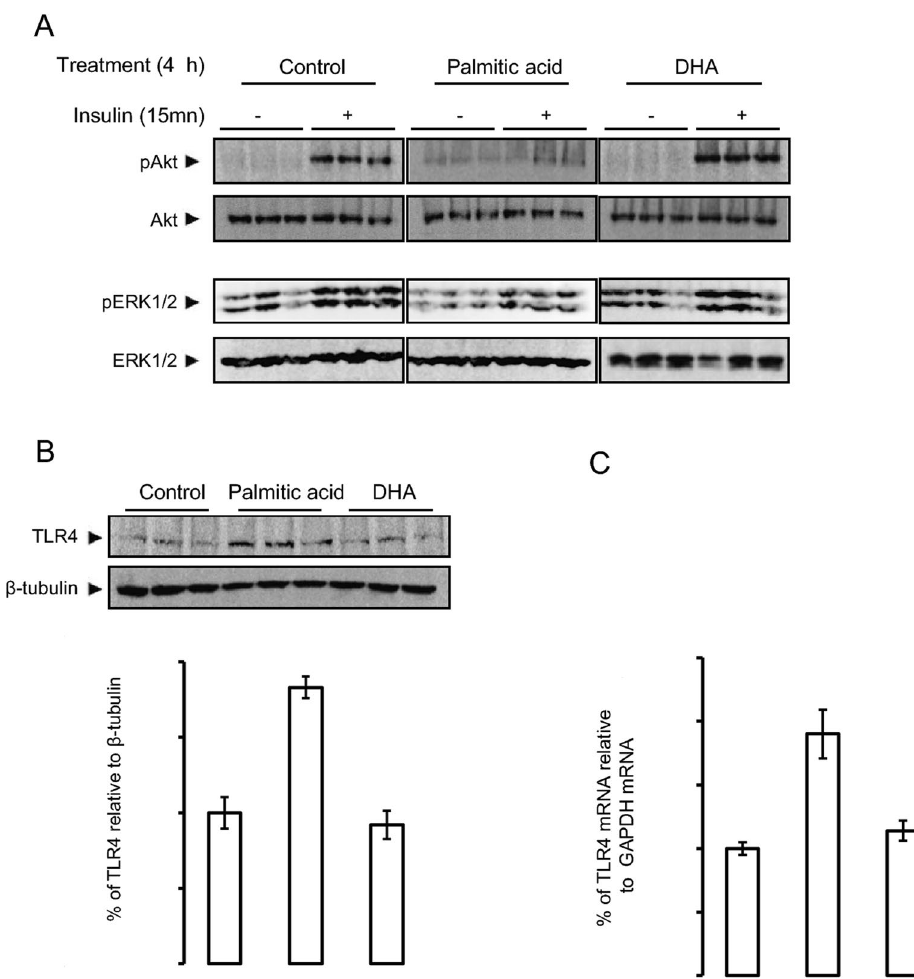
Figure 1. Palmitic acid but not DHA, inhibits insulin action and up-regulates TLR4. Human SH-Y5Y neuroblastoma cells were pretreated with palmitic acid, DHA or placebo during 4 h, then insulin-dependent Akt and ERK1/2 phosphorylation measured by Western blots using adequate antibodies, Control, Palmitic acid and DHA blots were performed in separate membranes, in each case the same membrane was blotted with different antobodies (panel A ); TLR4 expression was measured by Western blot using anti-TLR4 antibodies and the expression was normalized to β tubilin, and band densities were quantified and expressed as ratio of TLR4/β- tubilin (panel B ); TLR4 mRNA expression was determined by qRT-PCR normalized to GAPDH (panel C ). Western blot and qRT-PCR data were presented as means ± SEM (n = 3), * and ** denoted significant differences vs control at p < 0.05 and p < 0.005,